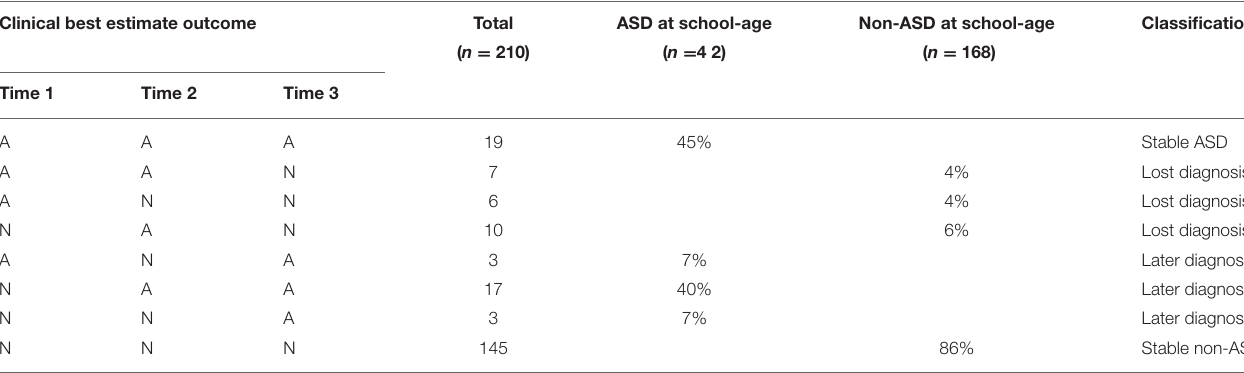
TABLE 2 | Patterns of Clinical Best Estimate outcome classifications by time point. Clinical best estimate